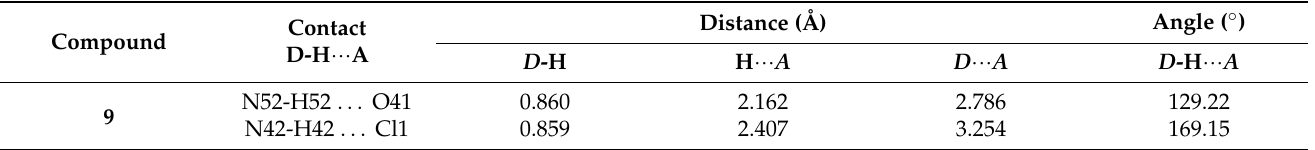
Table 3. Intramolecular H-bonding interactions for complex 9 .